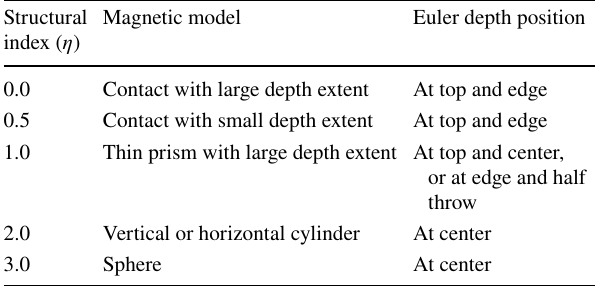
Table 1 Structural index and their corresponding magnetic models (After Hsu